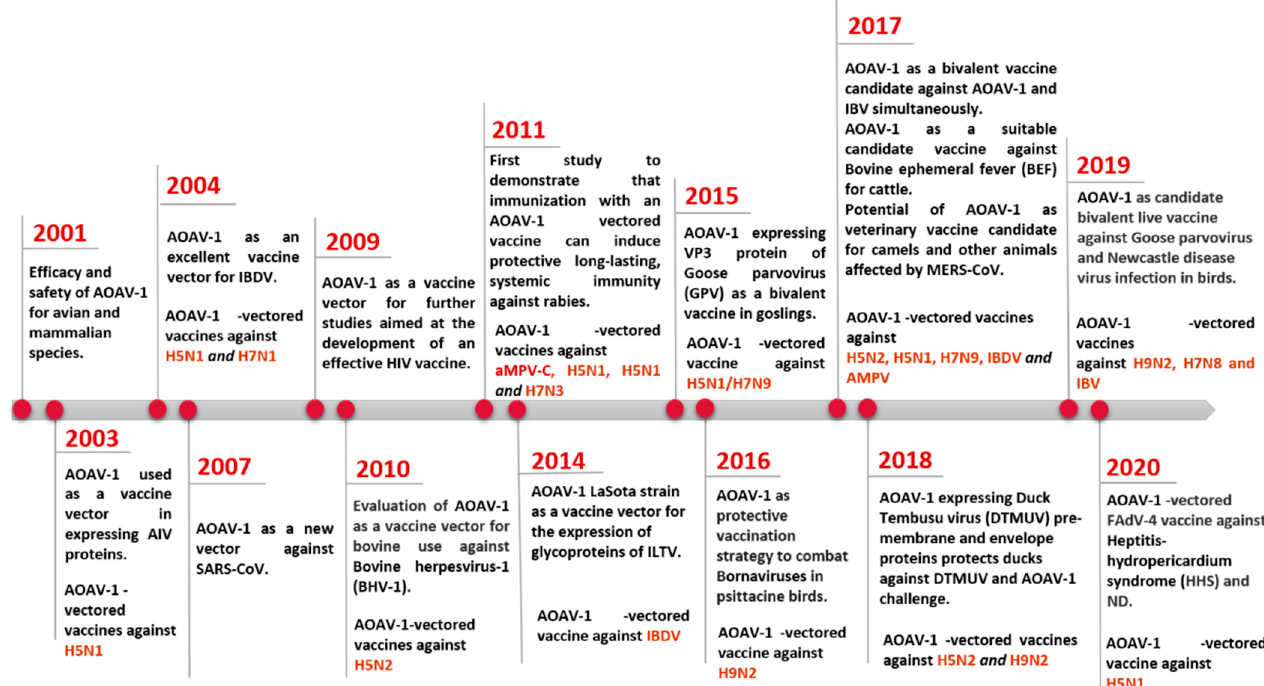
Figure 1. Progress on the use of AOaV-1 as viral vector for vaccine development.